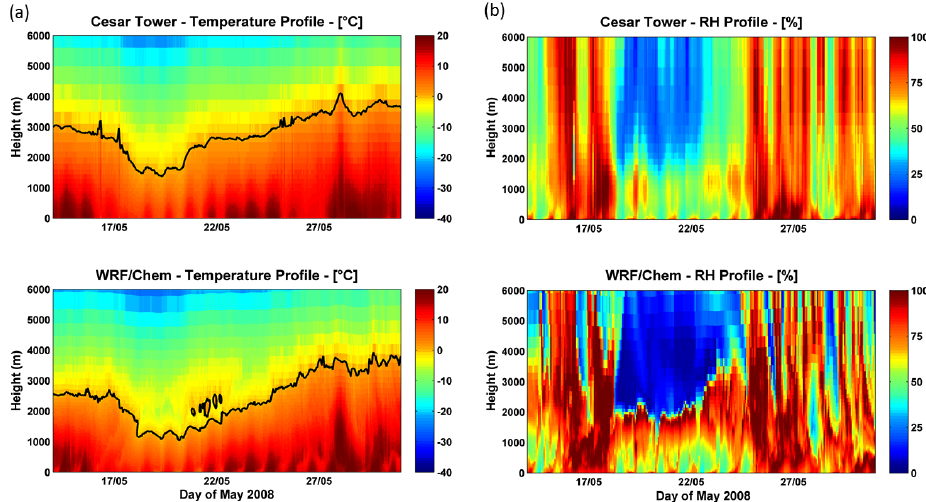
Figure 2. Observed and simulated time series of vertical profile of the temperature (a) and relative humidity (b) , observed at Cesar observa- tory. The black line on the temperature profile represents the 0 ◦ C